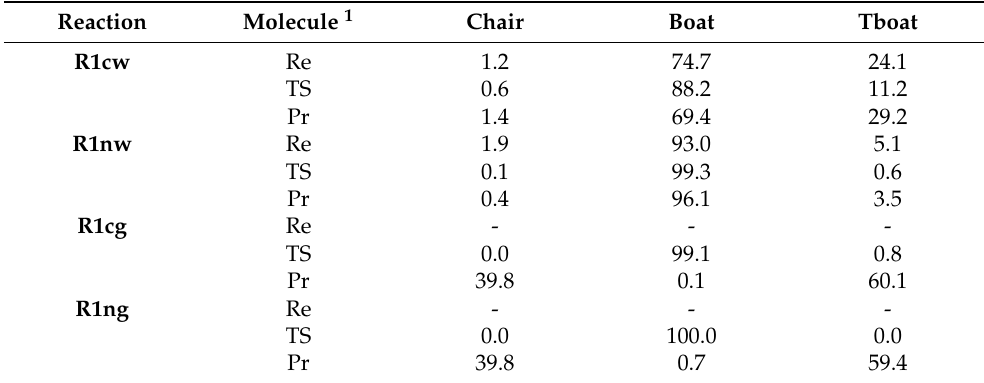
Table 4. Contribution (%) of the chair, boat, and tboat forms of the six-membered ring at the stationary points of the reaction R1 . B3LYP/6-311+G(2d,p)/AMBER level of theory in water solution, and B3LYP/6-311+G(2d,p) level of theory in the gas phase. Reaction Molecule 1 Chair